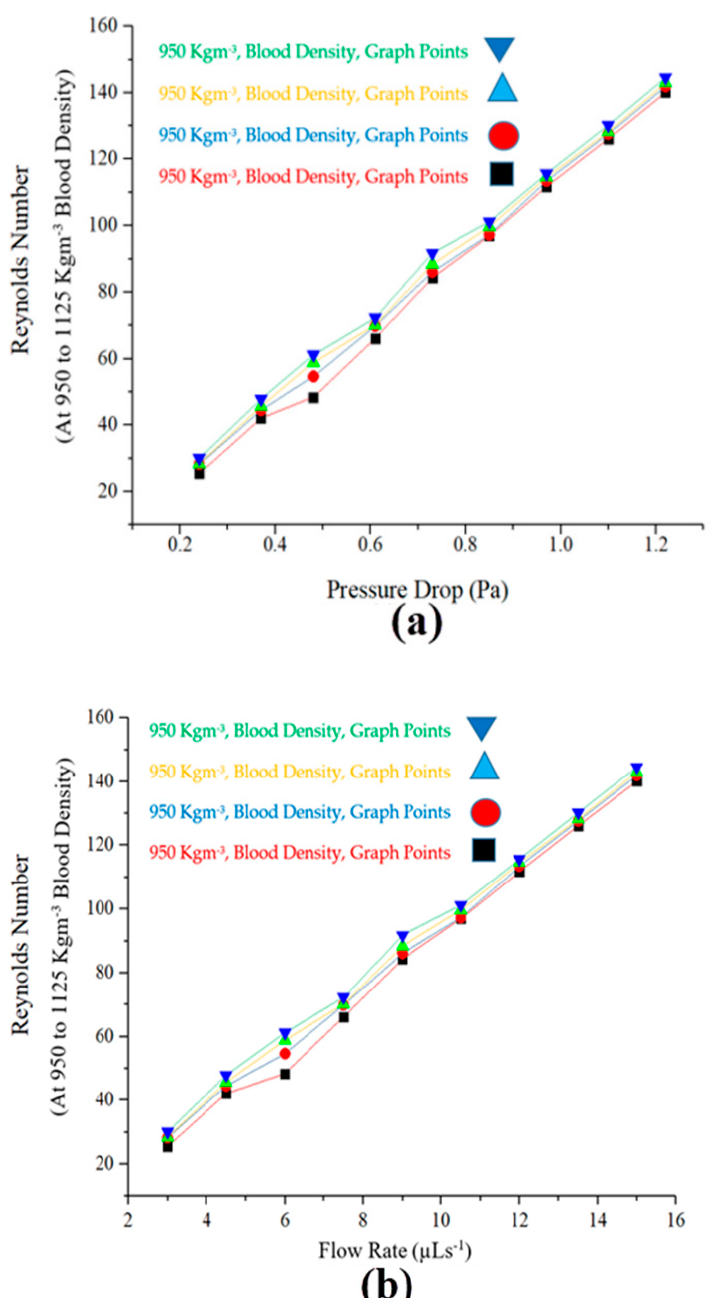
Figure 13. ANSYS Fluent Simulation graphs for 5CDCMC ( a ) Reynolds number and pressure drop ( b ) Reynolds number and flow rate.